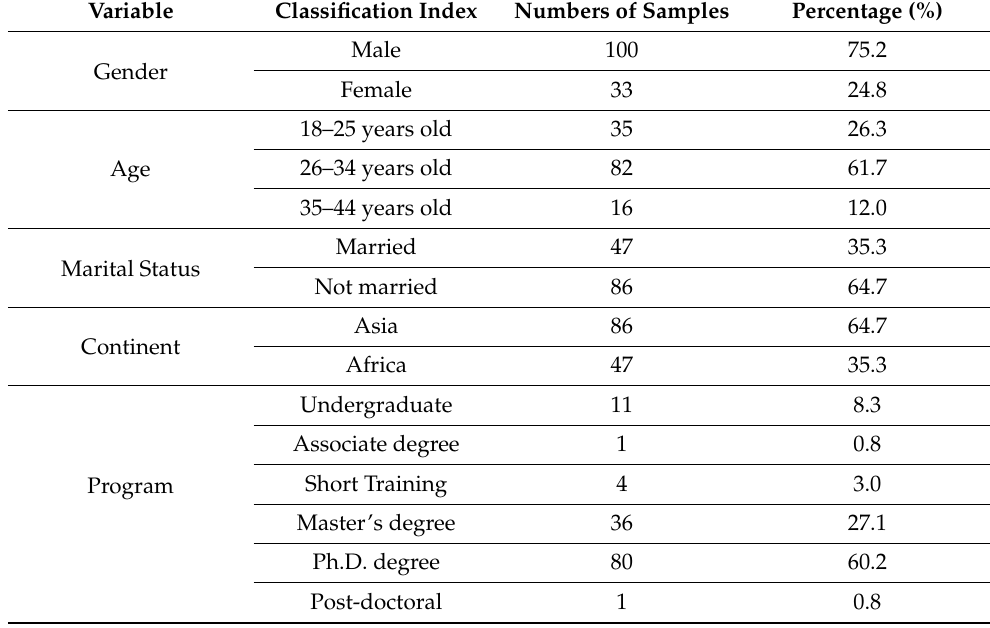
Table 1. Demographic Characteristics of